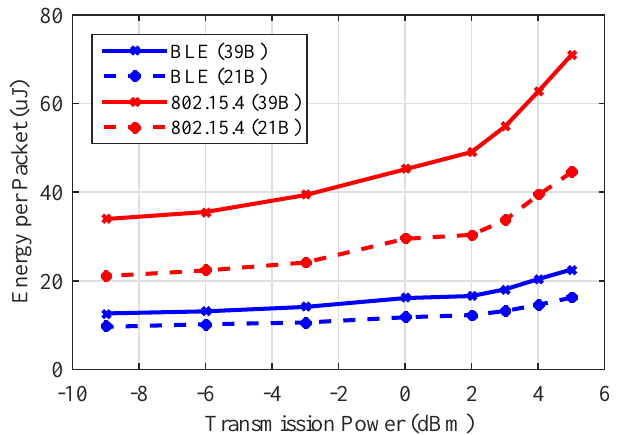
Figure 2. Empirical PER vs. RSSI curves for two different PHY payload